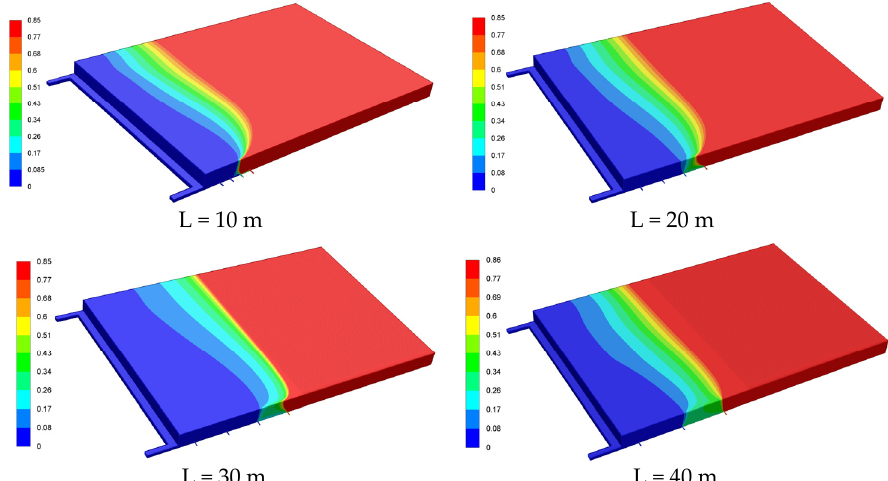
Figure 4. The distribution of methane concentration under different borehole spacing.